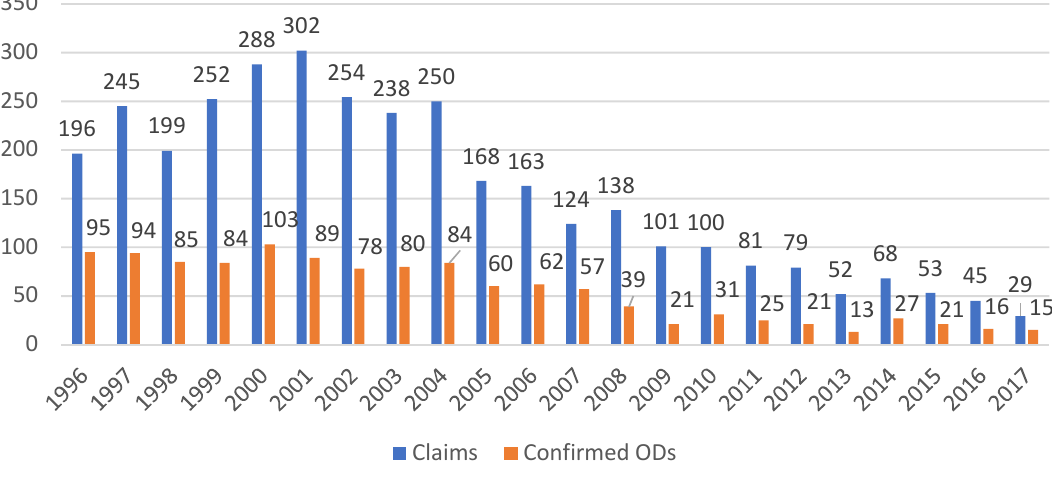
Figure 1. Hepatitis B: Claims and confirmed ODs from 1996 to 2017. Average confirmation rate for hepatitis B virus (HBV): 24.3% (total number of claims: 2817; total number of confirmed ODs: 685)